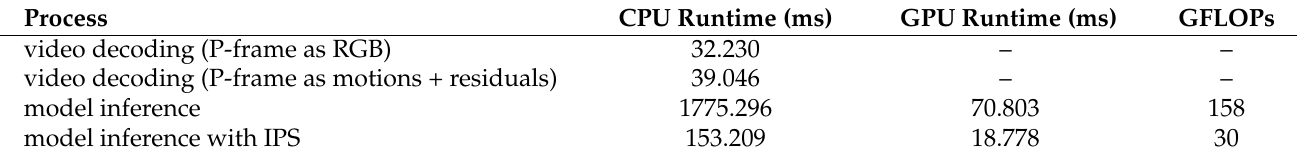
Table 2. Comparison of costs per video for decoding and model inference on HMDB-51. The recognition model is TimeSformer-S with Joint Space-Time attentions. ”ms” stands for